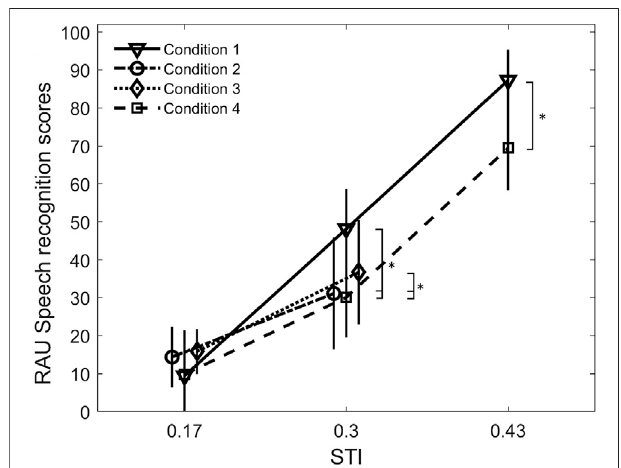
FIGURE 1 | Median RAU speech recognition scores for the GÖSA with corresponding interquartile ranges for different STIs and the measurement conditions listed in Table 1 . Stars indicate statistically signi fi cant differences across measurements